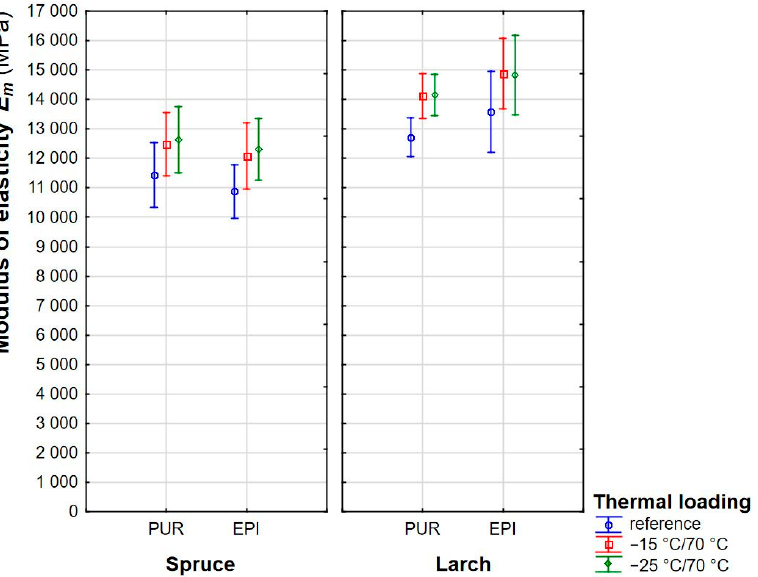
Figure 7. The effect of wood species, adhesive type, and temperature loading on the modulus of elasticity.